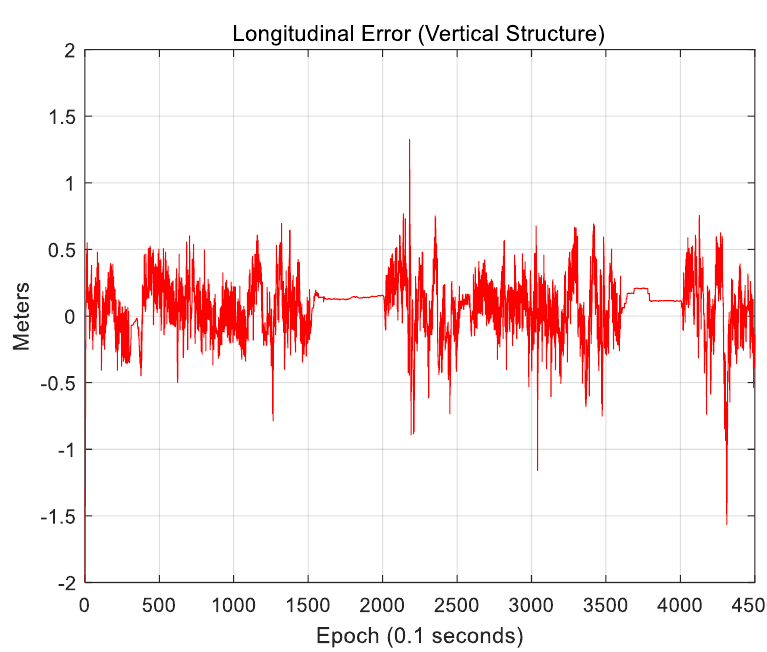
Figure 28. Longitudinal position error (vertical structure).